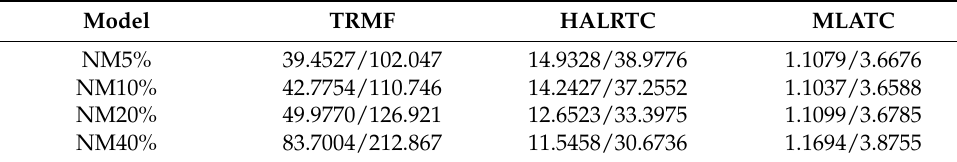
Table 4. Evaluation metrics for data prediction in the NM case (MAPE/RMSE).